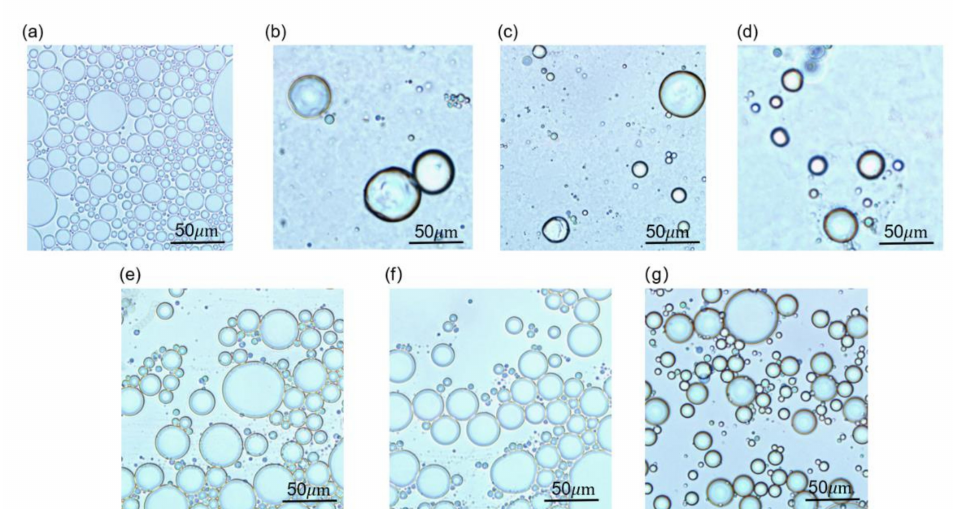
Figure 4. Microscopy images of emulsions emulsified by ( a ) SDS, ( b ) unmodified hectorite, ( c ) hectorite-C18, ( d ) hectorite-C18-V, ( e ) hectorite-2C18, ( f ) hectorite-2C18-V, ( g ) hectorite-2C18- 2V were captured after the as-obtained emulsions were stored for 24